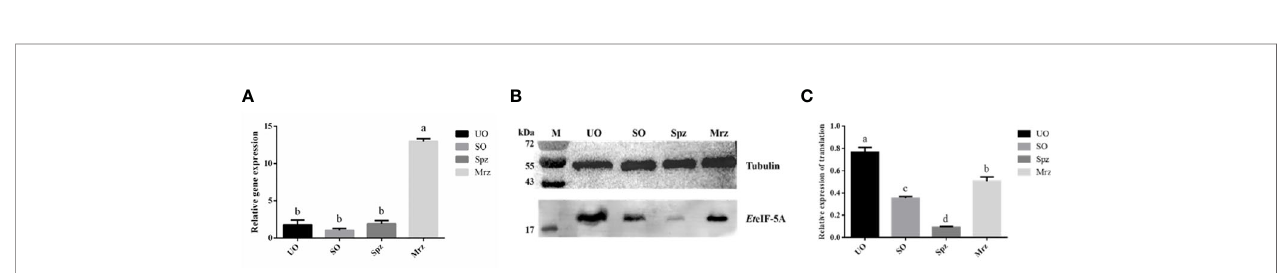
FIGURE 7 | Transcript and protein level of Et eIF-5A. UO, unsporulated oocysts; SO, sporulated oocysts; Spz, sporozoites; Mrz, second-generation merozoites. Anti- a -tubulin antibody was used as a loading control. The lysate of different stages of E. tenella was probed with rabbit anti-r Et eIF-5A. mRNA expression levels (A) and protein expression levels (B, C) of Et eIF-5A at four developmental stages of E. tenella . Data are means and standard deviations of three independent experiments performed in triplicate.